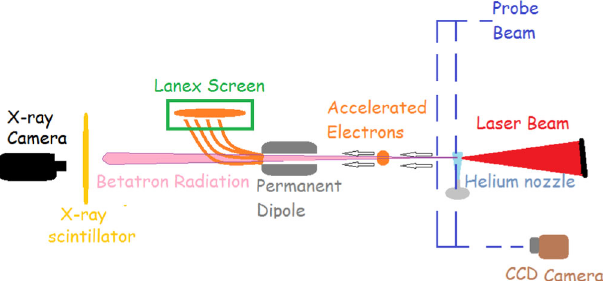
FIG. 1. The FLAME laser beam is focused on the He gas jet. Electrons are accelerated in the blowout regime over a distance ≳ 1 . The permanent dipole ( ≲ 1 T) coupled with a